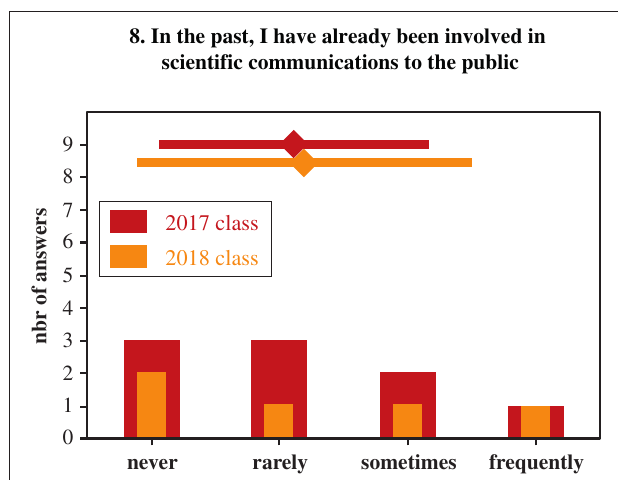
FIGURE 3 | Most M.Sc. students have no or only little experience in communication to a non-scientific public. This skill is very important in academia, governmental and non-governmental agencies and